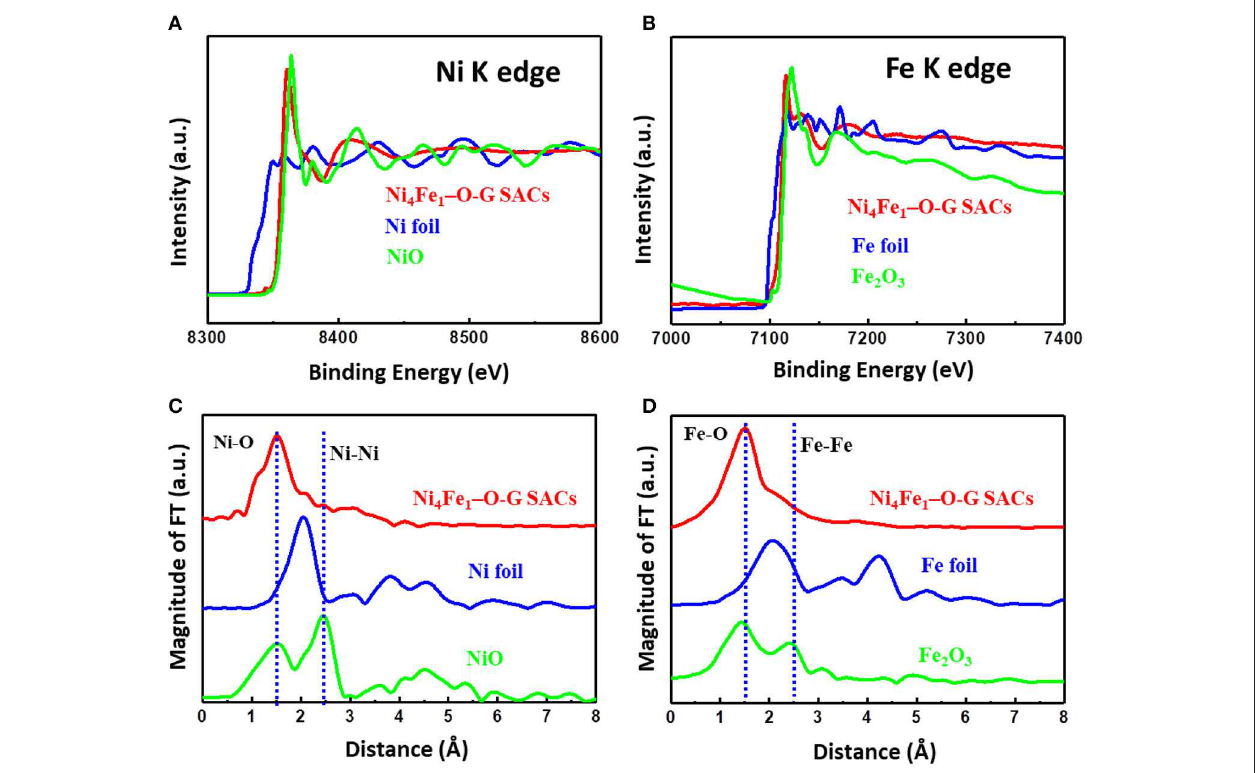
FIGURE 3 | (A) Ni K-edge XANES of Ni 4 Fe 1 -O-G SACs, Ni foil and NiO. (B) Fe K-edge XANES of Ni 4 Fe 1 -O-G SACs, Fe foil and Fe 2 O 3 . (C) Ni K-edge FT-EXAFS spectra of